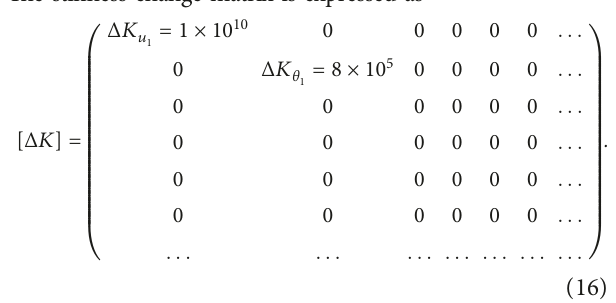
Figure 11: Evolution of the natural frequencies for different values of (a) Δ K Fixed-free configuration ( X